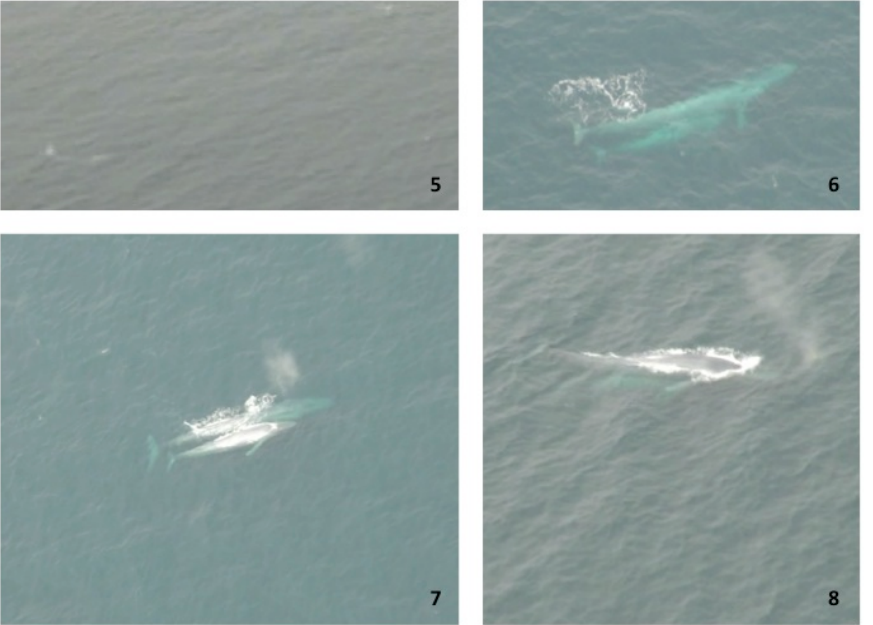
Figure 5. Photo of a blue whale adult pair ( 5 ) and photos of a mother-calf pair ( 6, 7, 8 ) within a group of six blue whales on 27 July 2010.